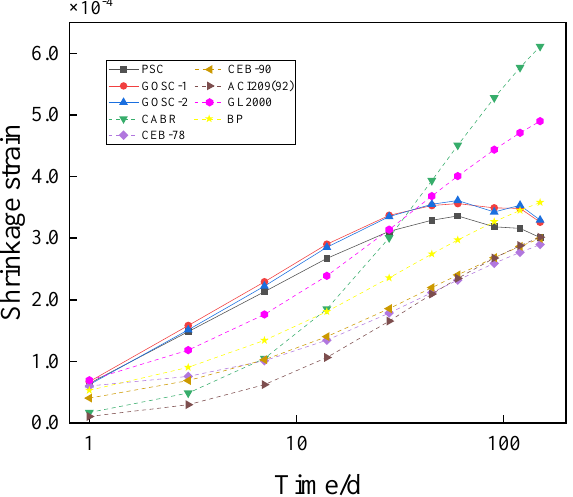
Figure 7. Comparison of the shrinkage strain between calculations and experimental results of the C50 concrete. (Note: the age of the concrete uses a logarithmic scale.).